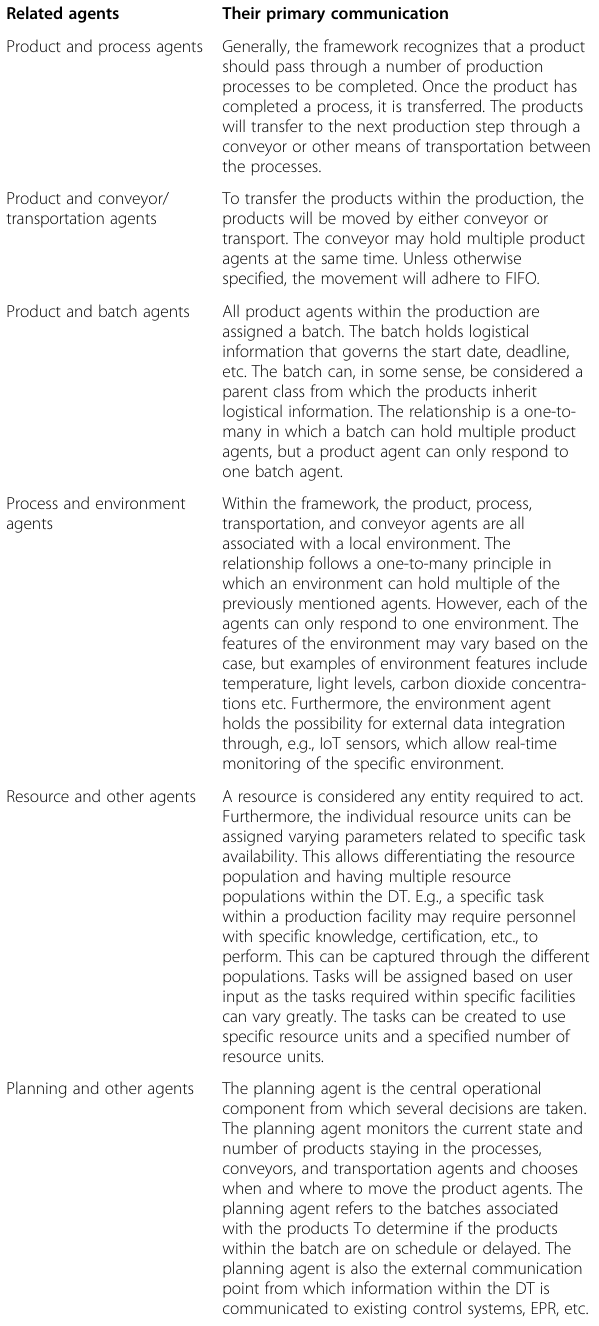
Table 2 (Abstract P9). Agent communication in the digital twin framework for industrial production processes Related agents